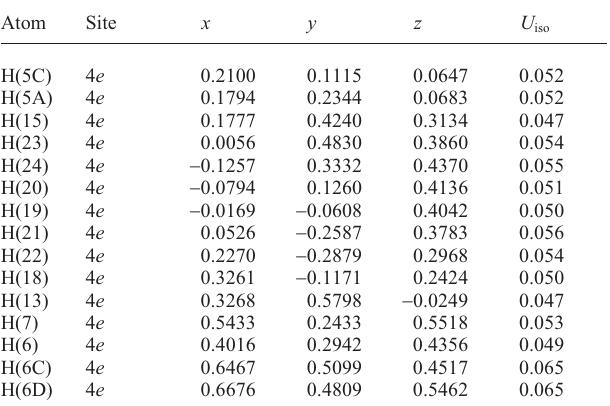
Table 2. Atomic coordinates and displacement parameters (in Å 2 )